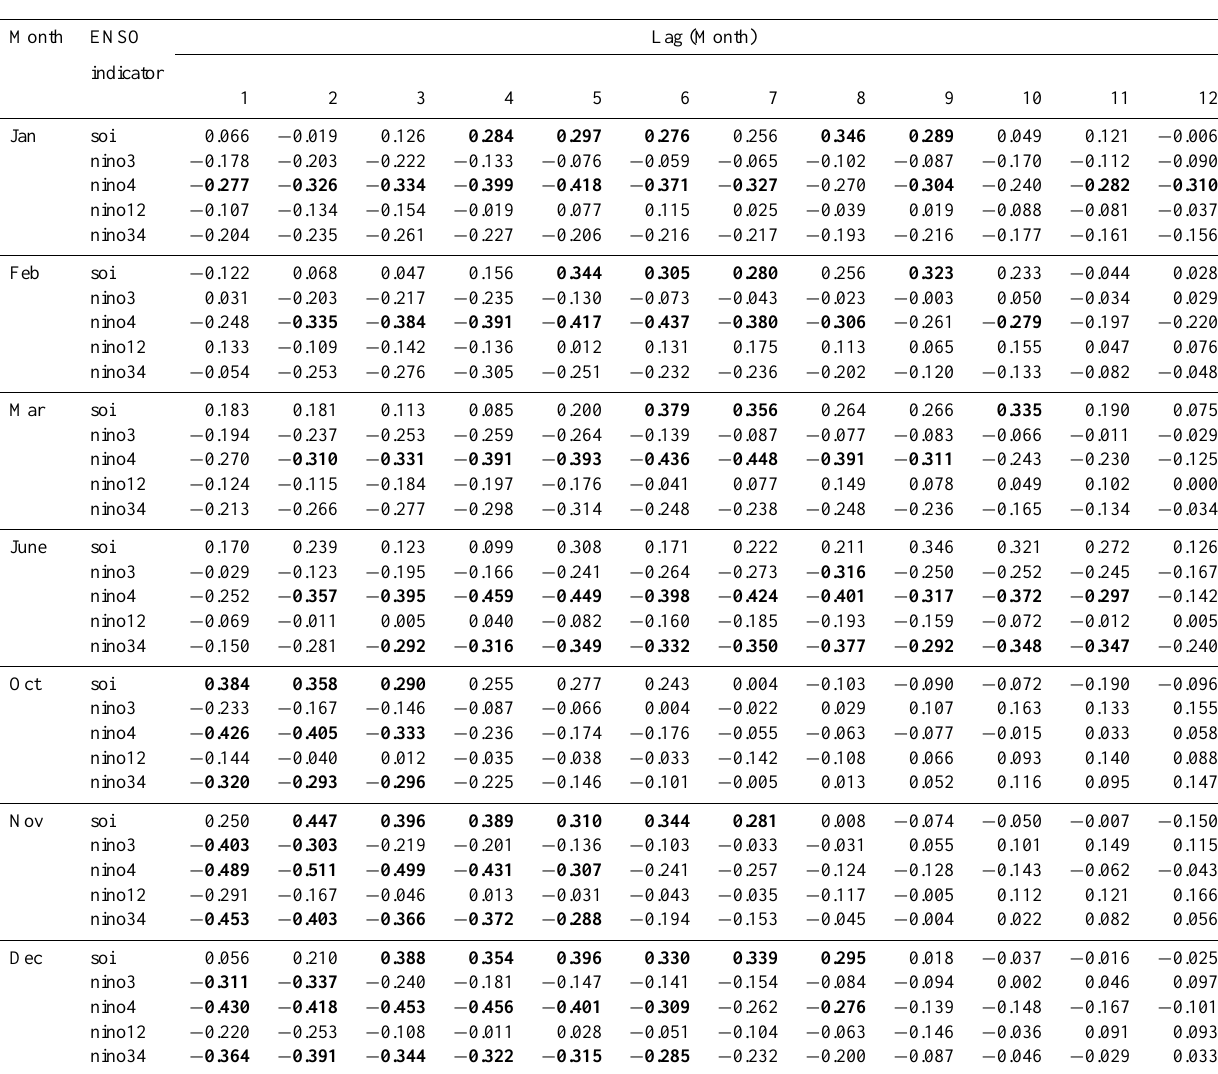
Table 3. The correlations between monthly streamflow and monthly ENSO indicators with different lag month. Month